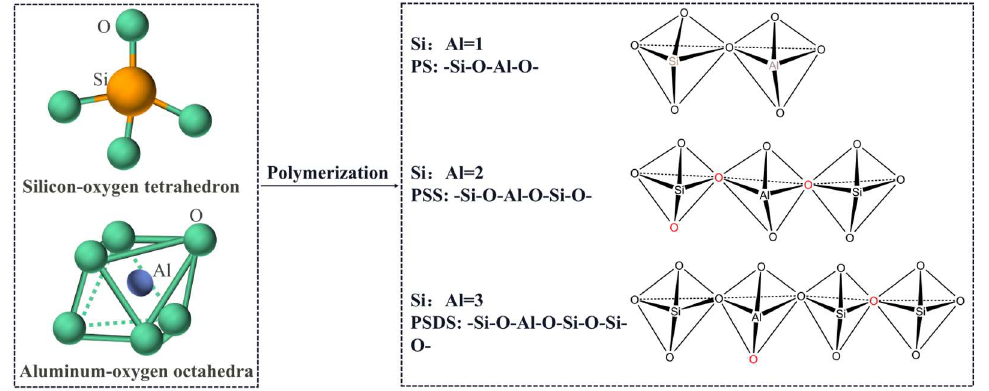
Figure 2. Schematic diagram of geopolymer structure.